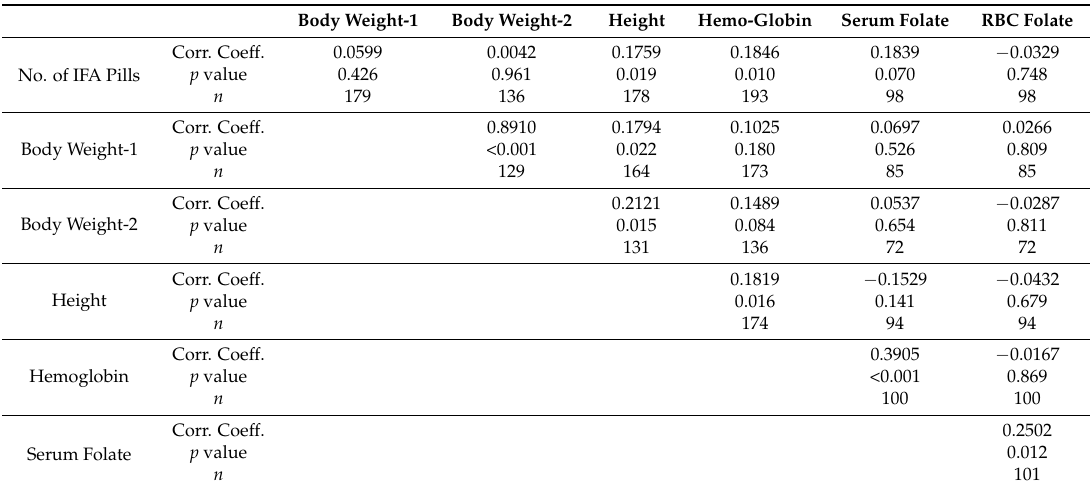
Table 3. Spearman’s correlation of prenatal iron and folic acid (IFA) supplement use with maternal characteristics.